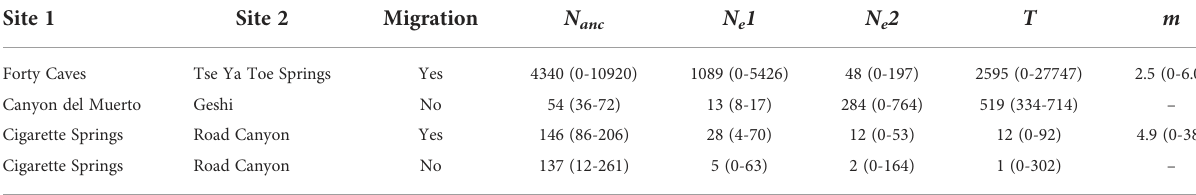
TABLE 2 Estimates of demographic parameters for pairs of hanging garden sites for the best supported model (i.e., Migration, which represents a model with migration [Yes] or without migration